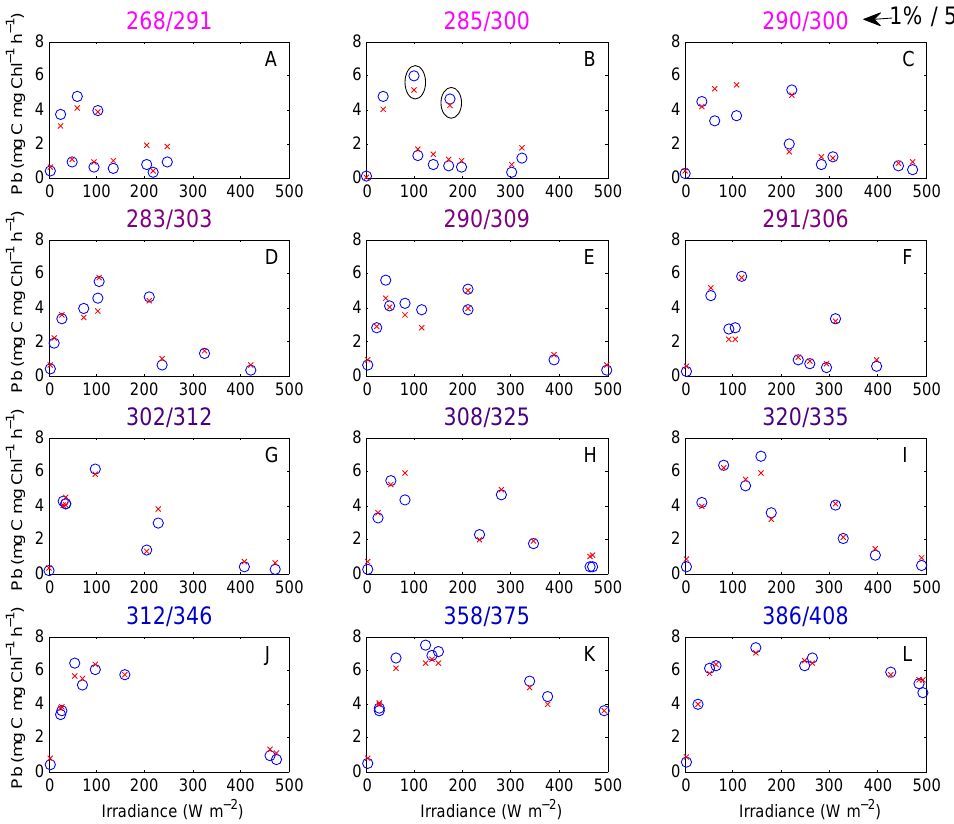
Figure 2. Representative set of photosynthesis measurements from a Synechococcus photoinhibitron experiment; shown are results from the exposure of a HL 26 ◦ C WH8102 culture plotted vs. PAR exposure (Wm − 2 ) of each treatment. Observed rate of photosynthesis (open circles) and predicted rate of phytosynthesis by the BWF E -PE model (x’s). Panel titles give the 1 and 50% wavelength cutoffs of the max spectral treatment shown in each panel, color coded on a gradient from short-wavelength UVB (magenta) to long-wavelength UVA (blue); further details are listed by panel letter in Table 1. Due to heterogeneity in the Xe lamp emission, spectral composition varies somewhat even within a spectral treatment. This causes some scatter in the P-E relationship (e.g., circled points) but does not affect the generally good agreement between observed and fitted. The root mean square error (RMSE) for the fit is 0.53 (mgCmgChl − 1 h − 1 )